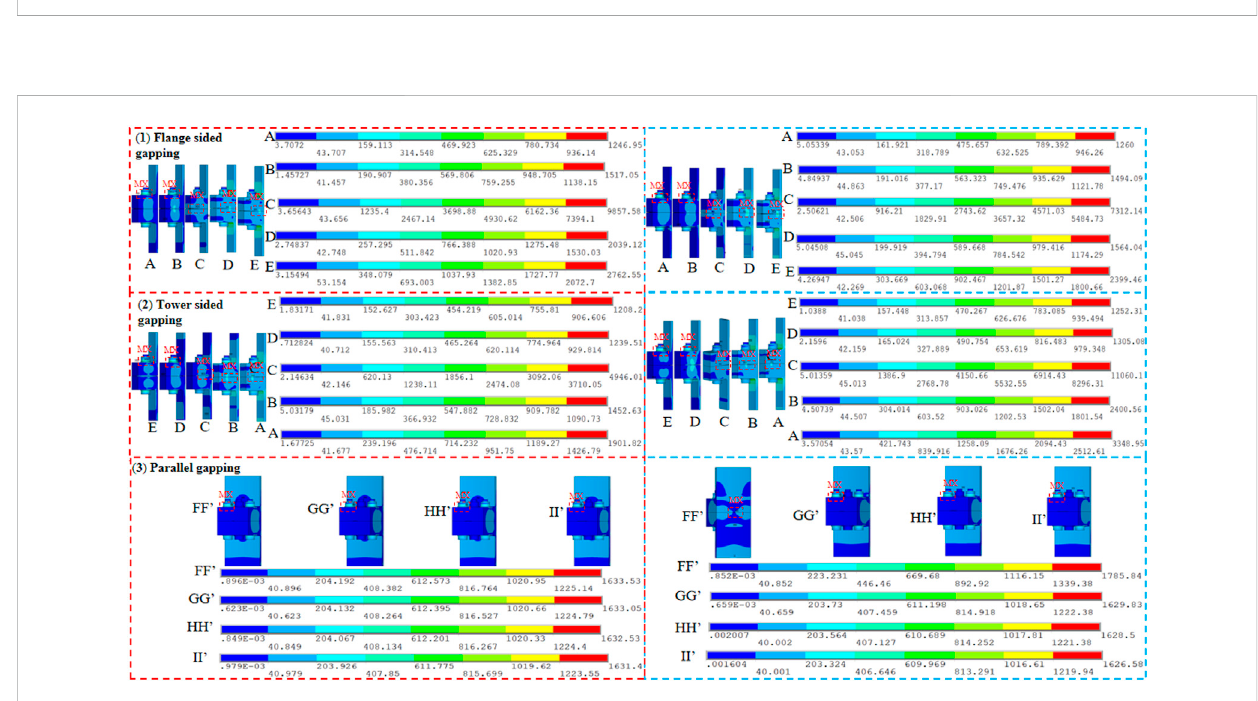
FIGURE 11 Von Mises stress state of the FOWTs ’ tower fl anges under initial fl atness divergence when subjected to tensile (left) and compressive stresses (right) (details of the location of openings are given in Figure